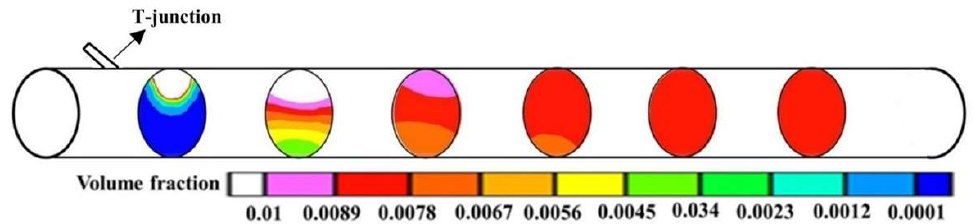
Figure 7. Section contour of the volume fraction of salt solution in the pipeline.